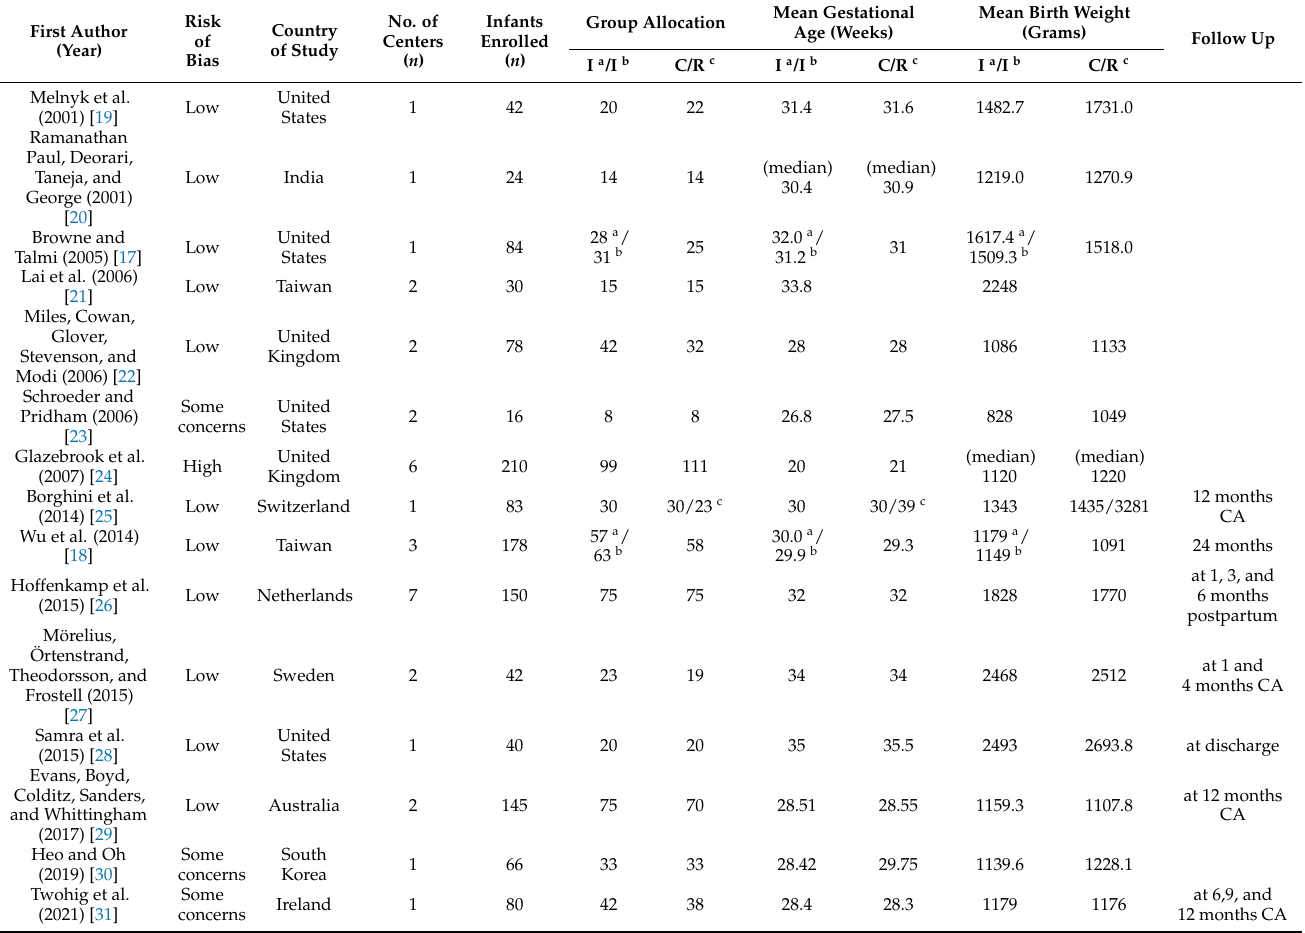
Table 1. Characteristics and methods of studies included in the review ( n =